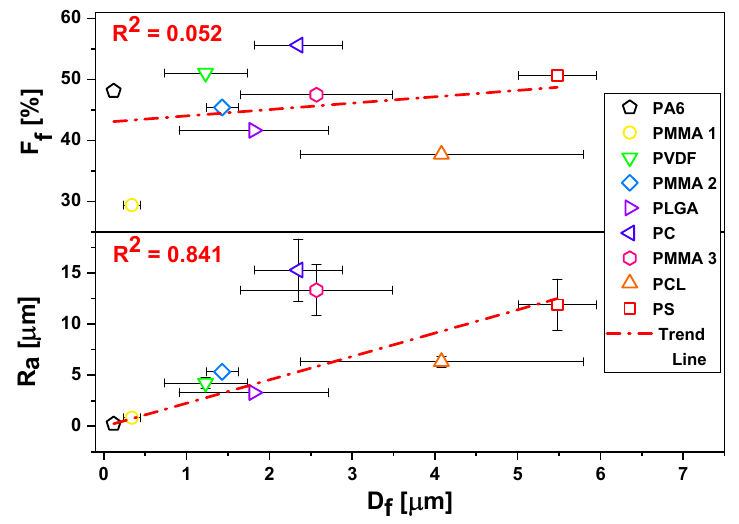
Figure 2. Roughness R a and fraction F f as a function of average fiber diameter, D f , in three-dimensional (3D) meshes.